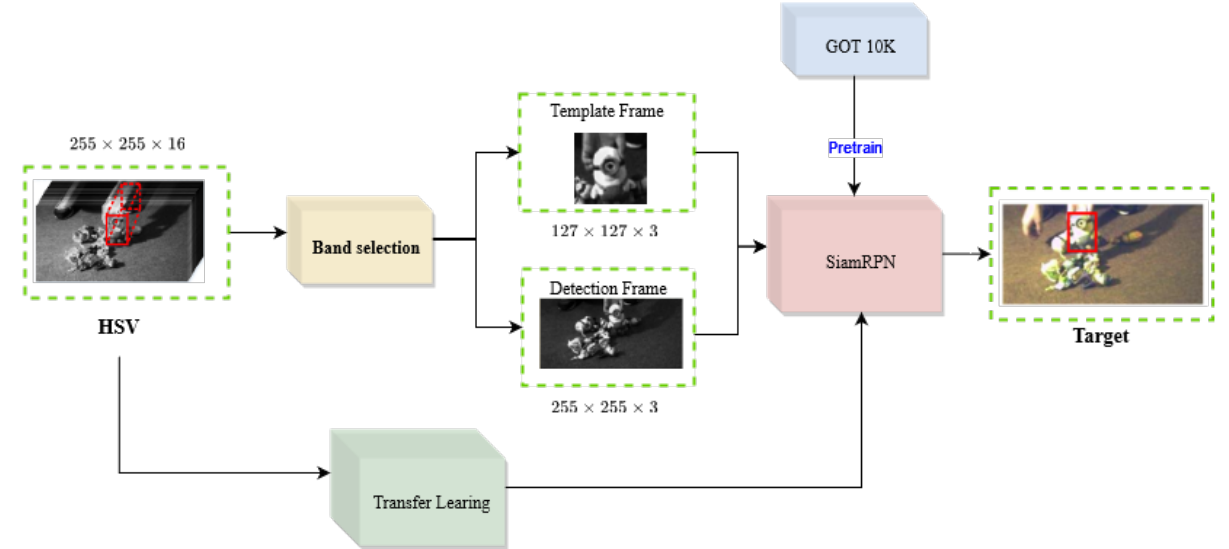
Figure 4. The flowchart of the proposed